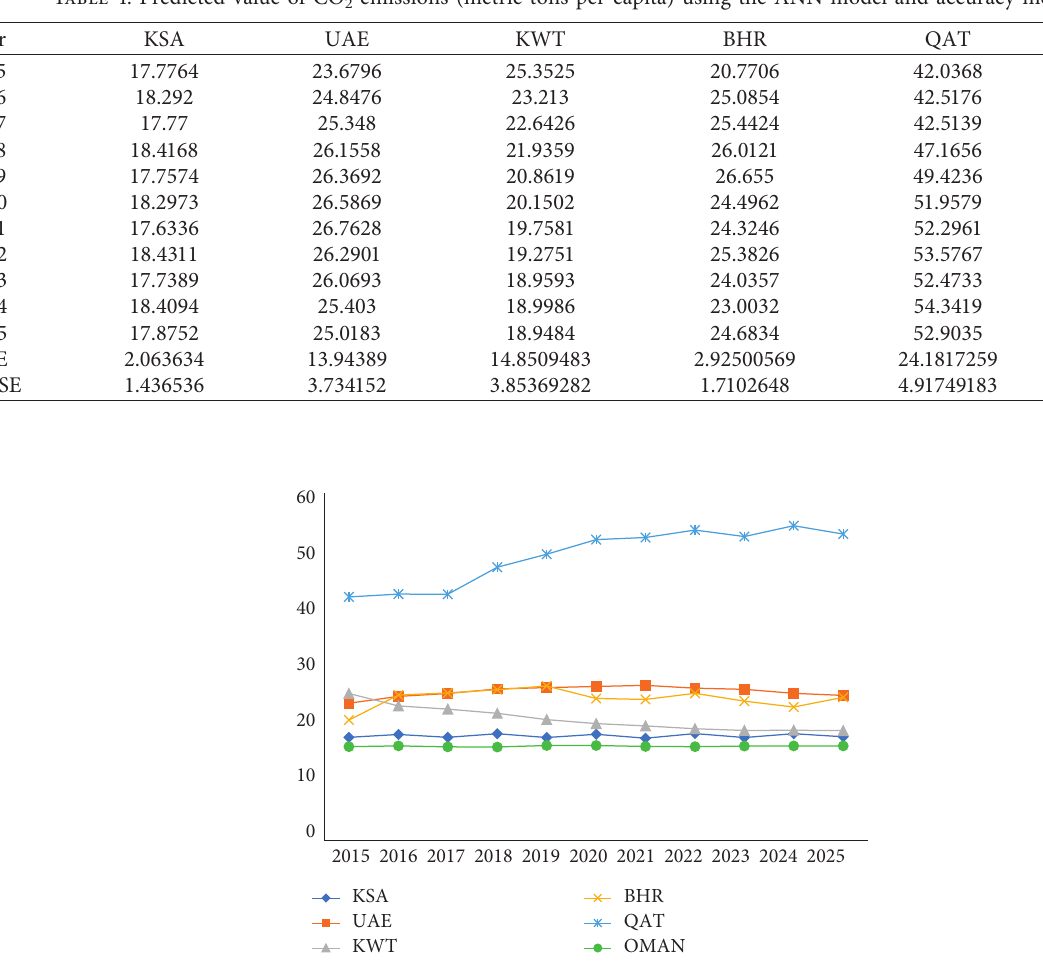
Figure 5: Predicted value of CO 2 emissions (metric tons per capita) using the ANN model. Table 5: Predicted value of CO 2 emissions (metric tons per capita) using the Holt-Winters exponential smoothing model and accuracy